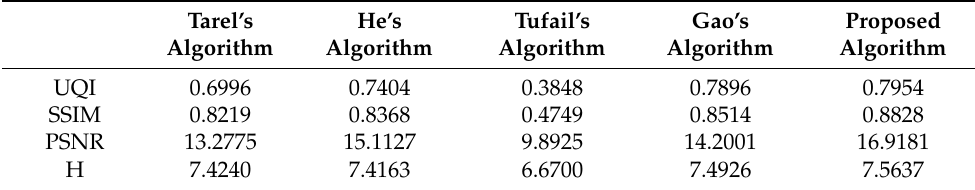
Table 1. Objective evaluation results on the first group of defogged images based on five defogging algorithms.